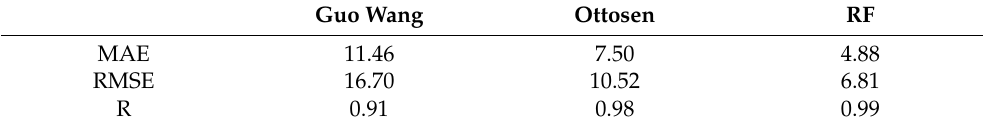
Table 2. Comparison between the neural network strength criterion model and classical strength criterion.